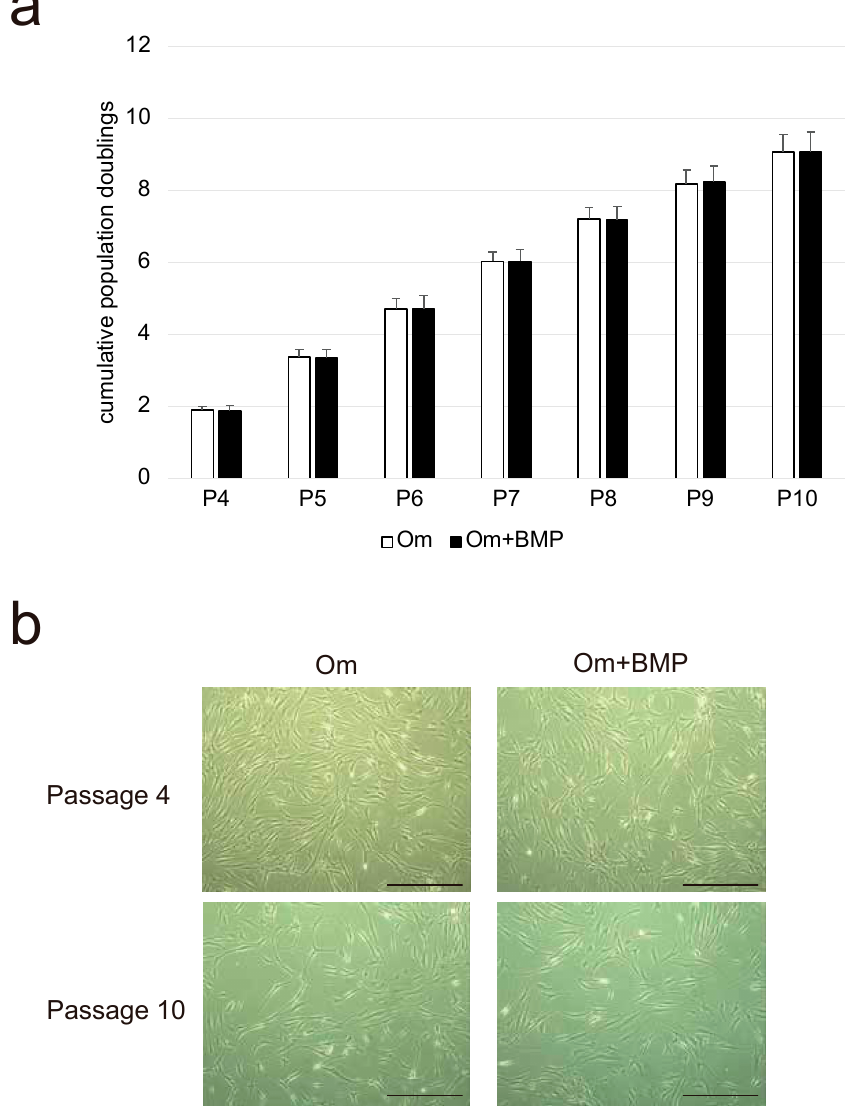
Figure 1. Evaluation of the proliferative capability of non-hypertrophic nonunion cells (NHNCs). ( a ) Cumulative population doubling (PD) values were determined for each subculture of NHNCs in original medium (Om) and Om with E-BMP-2 (Om + BMP). ( b ) Phase-contrast images of adherent NHNCs with Om and Om + BMP displaying fibroblastoid morphology at passages 4 and 10. Scale bar = 500 μ m.